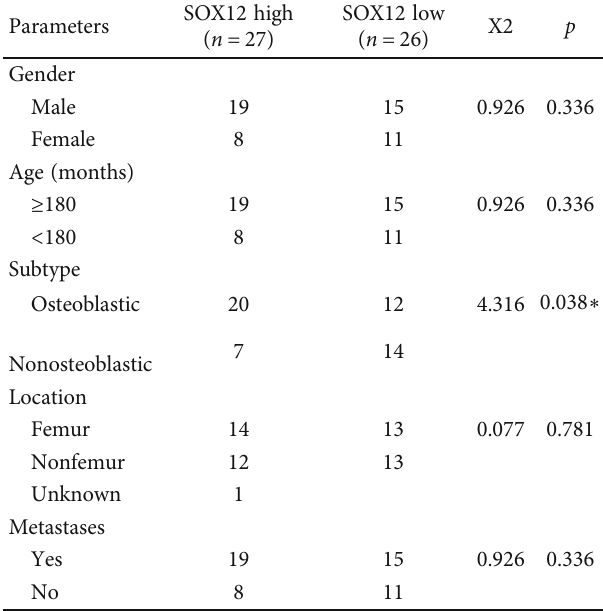
2: Association between SOX12 expression and clinicopathological parameters in GSE21257.